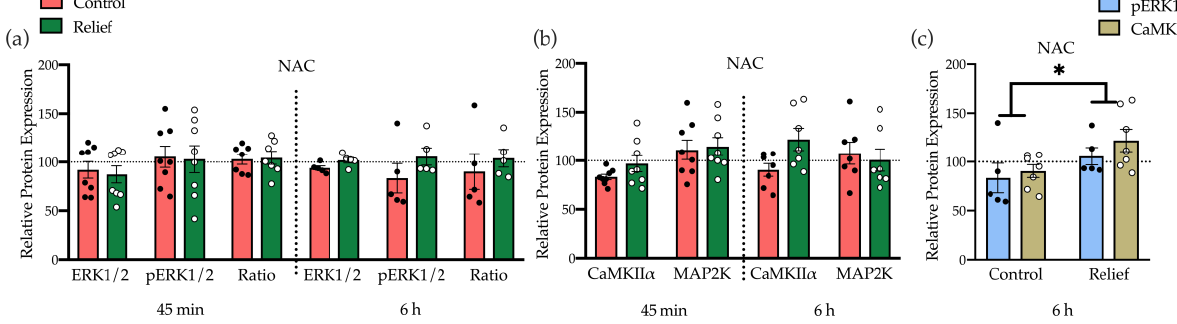
Figure 4. Expression level of ERK1/2, CaMKII α , and MAP2K in NAC. ( a ) Expression and phosphorylation level of ERK1/2 and ( b ) expression level of CaMKII α and MAP2K in NAC 45 min, and 6 h after control and relief conditioning. There were no significant differences. ( c ) Analyzing the expression of pERK and CaMKII α together showed significant differences in the relief-conditioned group. Bar diagrams depict the mean ± SEM ( n = 5–8/group; * p ≤ 0.05).